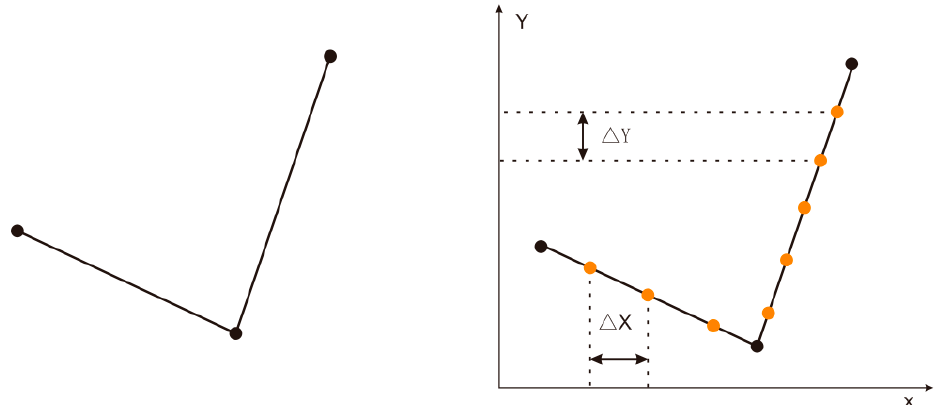
Figure 14. Average interpolation method with fixed length of stroke. ( a ) Shows pipeline and ( b ) shows the results after average interpolation method with fixed length.